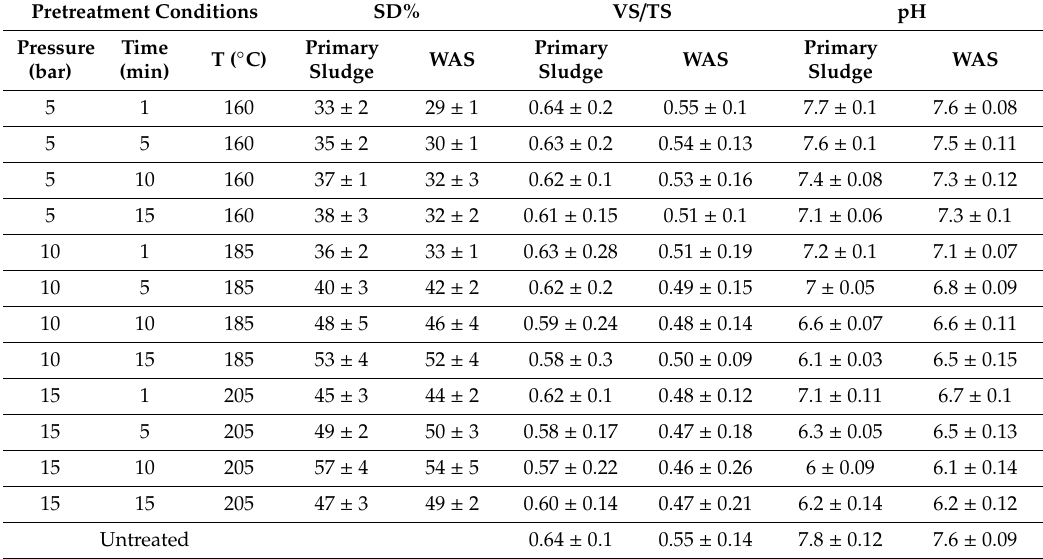
Table 1. Changes in properties of primary sludge (PS) and waste-activated sludge (WAS) by steam explosion pretreatment.